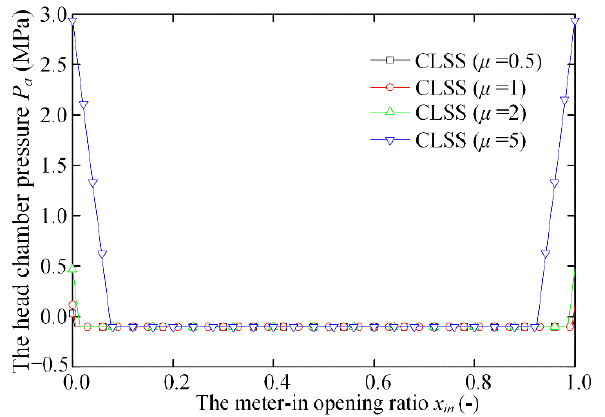
Figure 13. The head chamber pressure P a of CLSS with extension working mode.